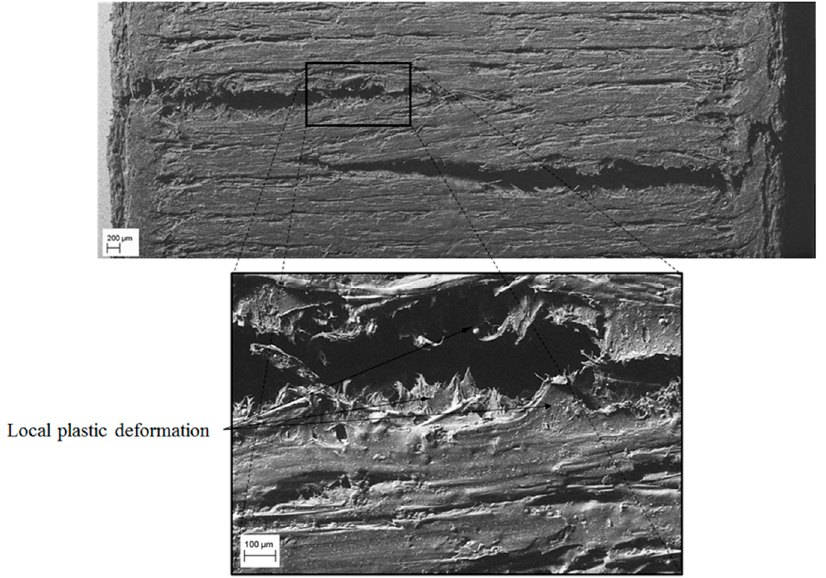
Figure 17. SEM images of the X-direction specimen—front view.